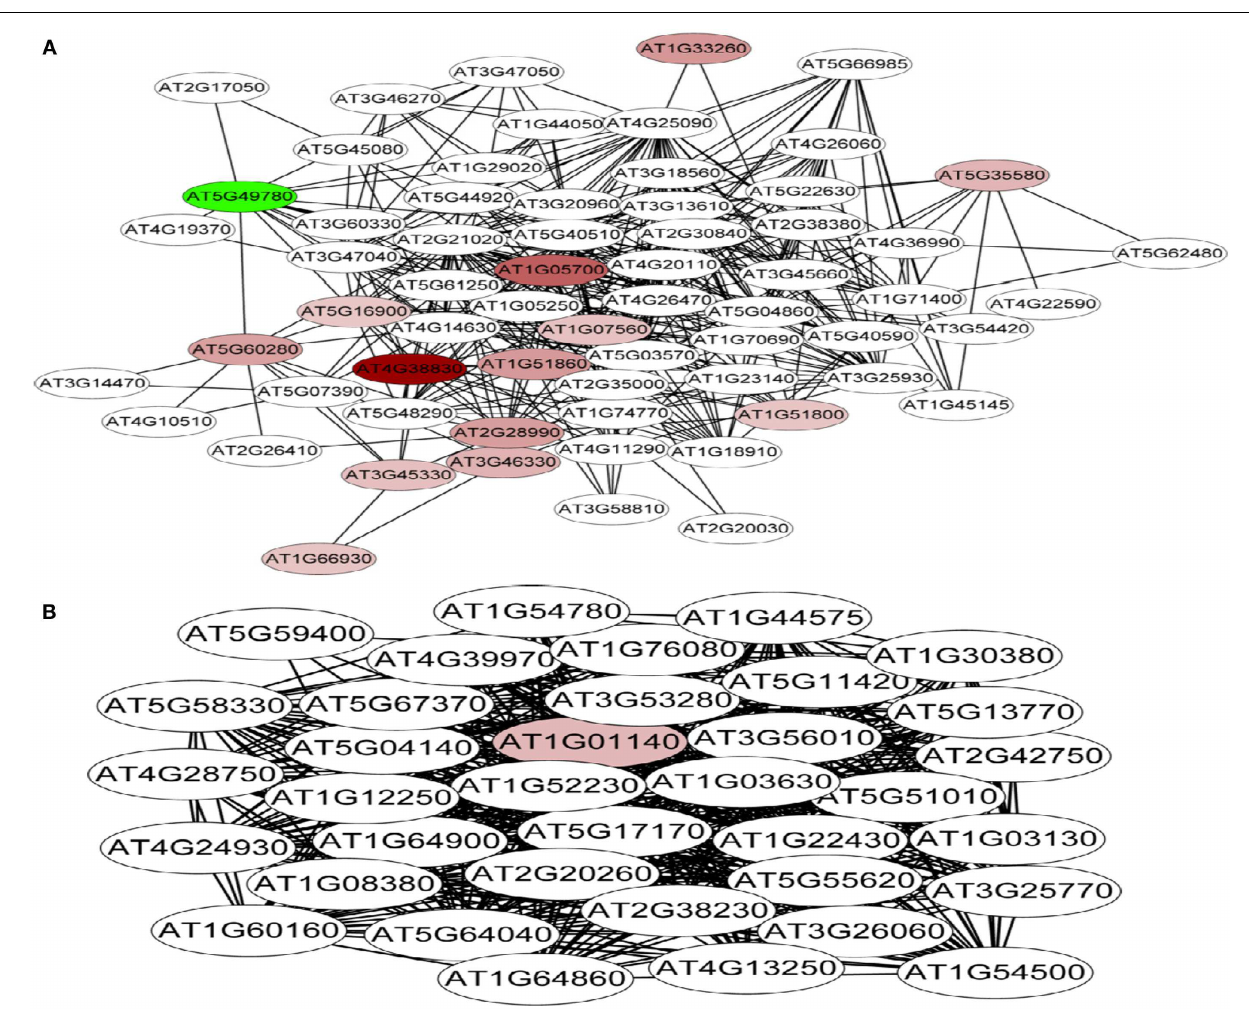
FIGURE 6 | Co-expression relationships of Fe-responsive genes with fold-changes greater than 1.5-fold in Arabidopsis roots . (A) Module FEPKPP2 and (B) module FEPKPP3. Red nodes indicate up-regulated PK genes, green nodes denote PK genes that are repressed by Fe deficiency, white nodes indicate fished